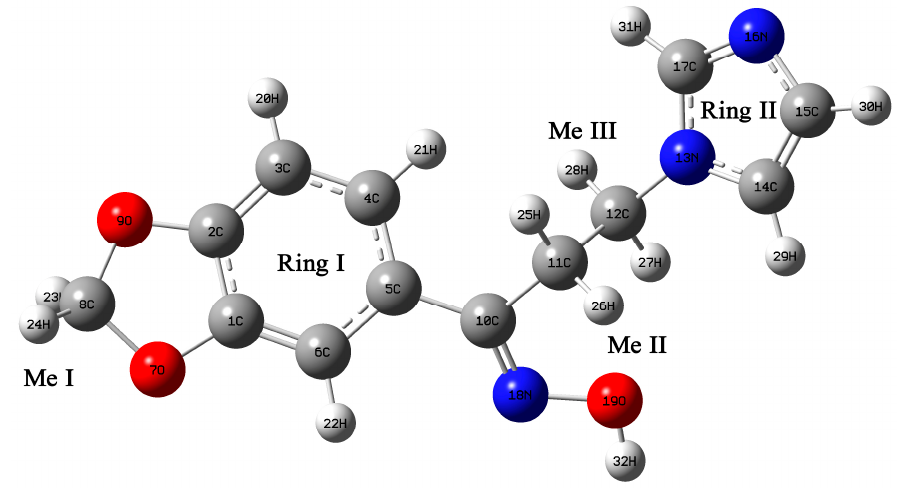
Figure 3. Optimized molecular structure of compound 4 .